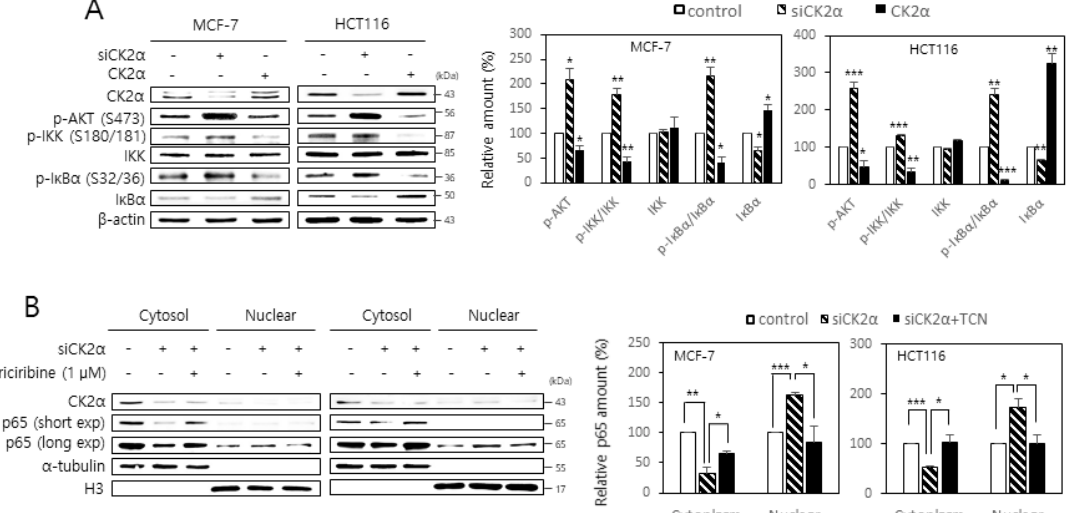
Figure 2. Activation of the AKT- I κ B kinase (IKK)-inhibitors of NF- κ B (I κ B) pathway is associated with the CK2 down-regulation-mediated nuclear import of NF- κ B. ( A ) MCF-7 and HCT116 cells were transfected with CK2 α siRNA or pcDNA3.1-HA-CK2 α for two days. The level of each protein was determined by immunoblot analysis using specific antibodies ( left ). Representative data from three independent experiments are shown. β -Actin was used as a control. Graphs represent the quantitation of p-AKT, IKK, and I κ B α relative to β -actin and that of p-IKK and p-I κ B α relative to the unphosphorylated proteins ( right ). ( B ) Cells were transfected with CK2 α siRNA or pcDNA3.1-HA-CK2 α for two days in the absence or presence of 1 μ M triciribine (TCN). Cytoplasm and nuclei were isolated from cells, and both extracts were visualized by immunoblotting. α -Tubulin (cytoplasmic marker) and histone H3 (nuclear marker) were quantified as loading controls ( left ). Representative data from three independent experiments are shown. Graphs represent the quantitation of RelA/p65 relative to the subcellular markers ( right ). exp, exposure. Data are mean ± SEM. * p < 0.05; ** p < 0.01; *** p < 0.001.